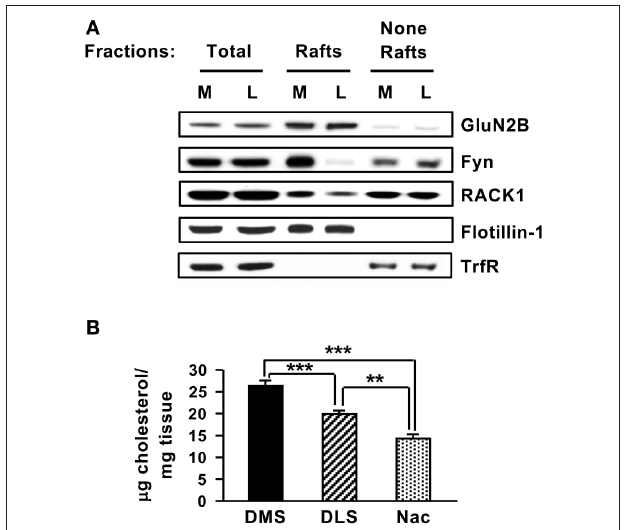
FIGURE 7 | Striatal subregions differ in lipid rafts composition and cholesterol content . (A) The DMS (M) and DLS (L) were dissected and subjected to lipid rafts fractionation using sucrose gradient. The upper, light weight, fractions (3–4) containing lipid rafts and the bottom, heavy weight fractions (none-rafts) (8–9) were pulled together. Samples were separated on SDS-PAGE gel, and the presence of GluN2B, Fyn, and RACK1 in or out of lipid rafts was determined by western blot analysis. The rafts marker Flotillin-1 and the non-rafts marker Transferrin receptor (TrfR) were used to validate the purity of the lipid rafts fractionation. (B) The DMS, DLS, and NAc were dissected and were subjected to cholesterol content analysis. Data are presented as the mean cholesterol value divided by tissue weight. Two-tailed t -test. *** p < 0.001 DMS vs. DLS, *** p < 0.001 DMS vs. NAc, ** p < 0.01 DLS vs. NAc, (A) n = 3, ( B ) n = 6 or